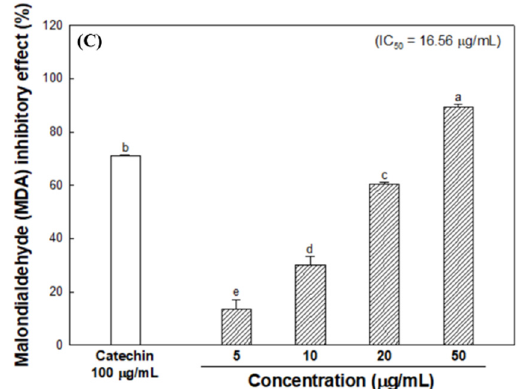
Figure 2. 2,2’-azino-bis-(3-ethylbenzothiazolin-6-sulfonic acid) diammonium salt (ABTS) radical scavenging activity ( A ), 1,1-diphenyl-2-picryl-hydrazyl (DPPH) radical scavenging activity ( B ) and malondialdehyde (MDA) inhibitory e ff ect ( C ) of the 60% ethanolic extract from Sorghum bicolor (ESB). Data were expressed as the means ± SD ( n = 3). Each small letter represented statistical difference, and was statistically considered at p < 0.05.